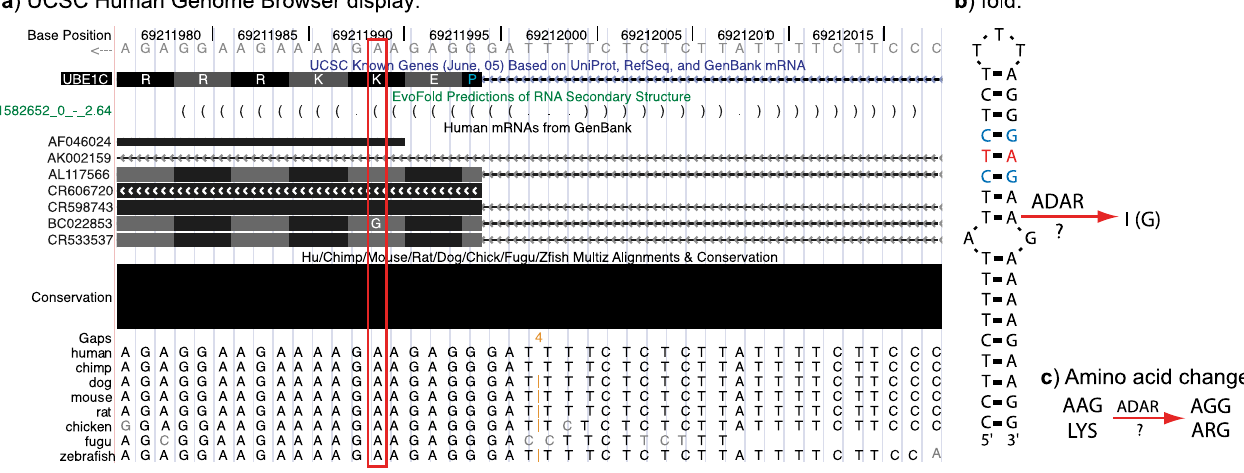
Figure 4. Candidate Substrate for A-to-I Editing (A) Gene structure, EvoFold predictions, cDNAs, conservation, and eight-way alignment are shown at the start of the second exon of the UBE1C gene. The predicted hairpin is shown in parenthesis format and can be seen to overlap the intron–exon boundary. The red box highlights a position where the genomic sequence contains an A and a cDNA contains a G. The orange bar and label ‘‘ 4 ’’ indicate that up to four extra bases are present in this loop location in the indicated species. (B) Depiction of hairpin (see Figure 3B for color legend) with indication of the potential site of ADAR editing (A-to-I). (C) Which would lead to a lysine to arginine amino acid change. DOI: